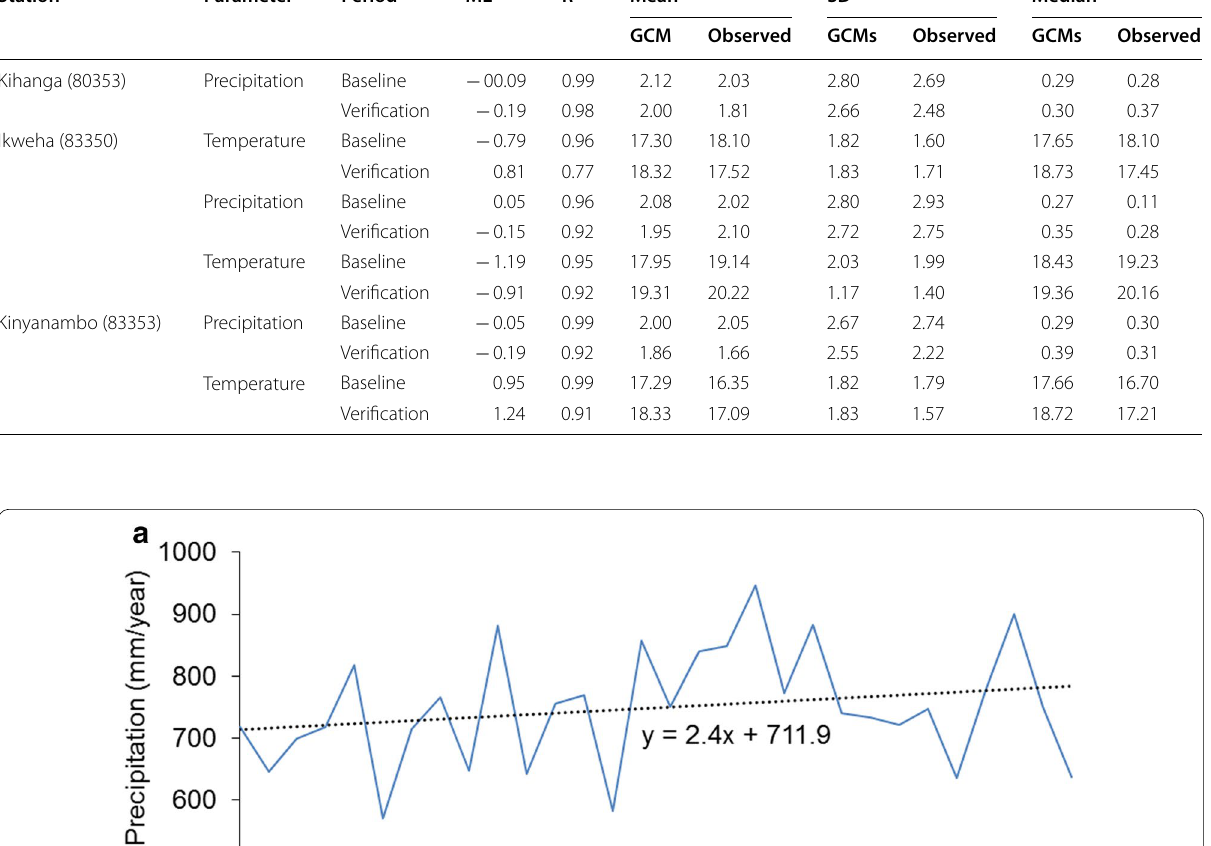
baseline period throughout the year (Fig. 17). The highest temperature change between the two periods was 1.5 °C in November for maximum temperature and 1.4 °C in June and July for the minimum temperature.